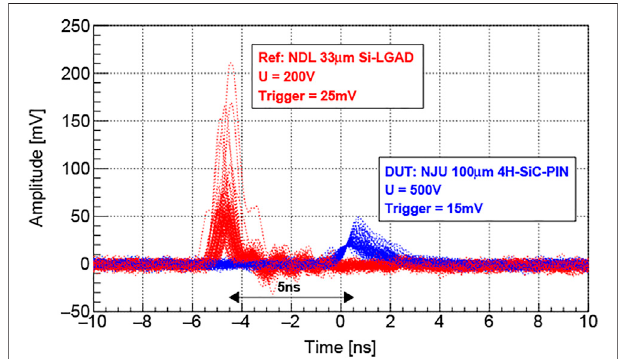
FIGURE 8 | Waveform sampling for Si-LGAD (red) and 4H-SiC-PIN (blue) as collected by an oscilloscope. The trigger thresholds are determined by thenoiselevel toeliminate allnoisespikes. The~5ns time delay of4H-SiC- PIN signals is caused by the additional, 1 m long